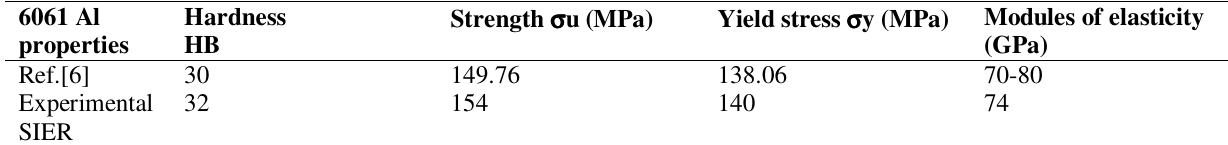
Mechanical properties of 6061 Al. alloy tested at SIER compared with the findings of Ref [6]. 6061